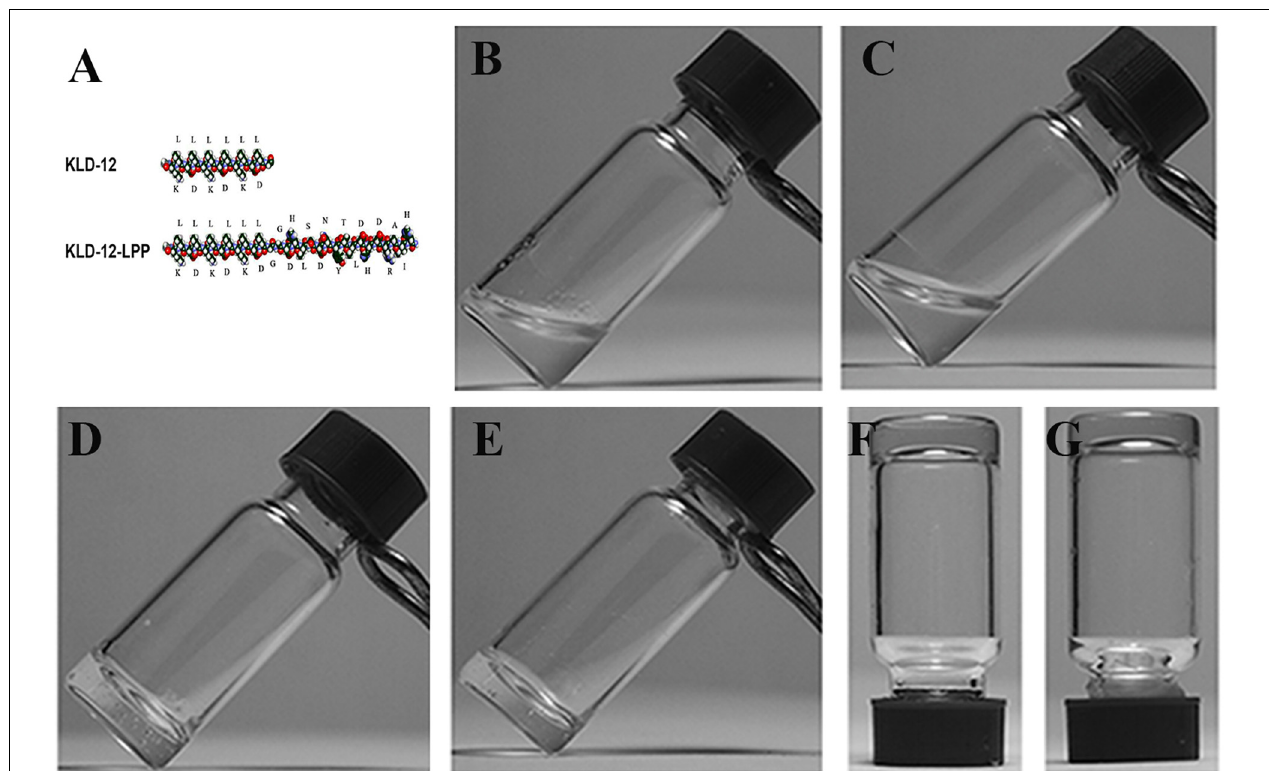
FIGURE 2 | (A) Molecular models of KLD-12 and KLD-12-LPP peptides. Peptide solutions after sonication: (B) KLD-12 solution and (C) KLD-12-LPP/KLD-12 mixed solution. Peptide hydrogels: (D) KLD-12 hydrogel and (E) KLD-12/KLD-12-LPP (KLPP) hydrogel. The gel strength of the hydrogels was enhanced by addition of CaCl2 solution. (F) KLD-12 hydrogel and (G) KLPP hydrogel.